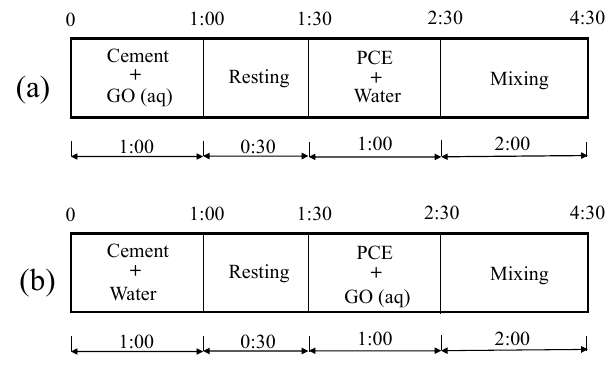
Figure 2. Mixing sequence of suspension or cement paste (unit: min): ( a ) Suspension No. 1 or Paste No. 1 and ( b ) Suspension No. 2 or Paste No. 2.